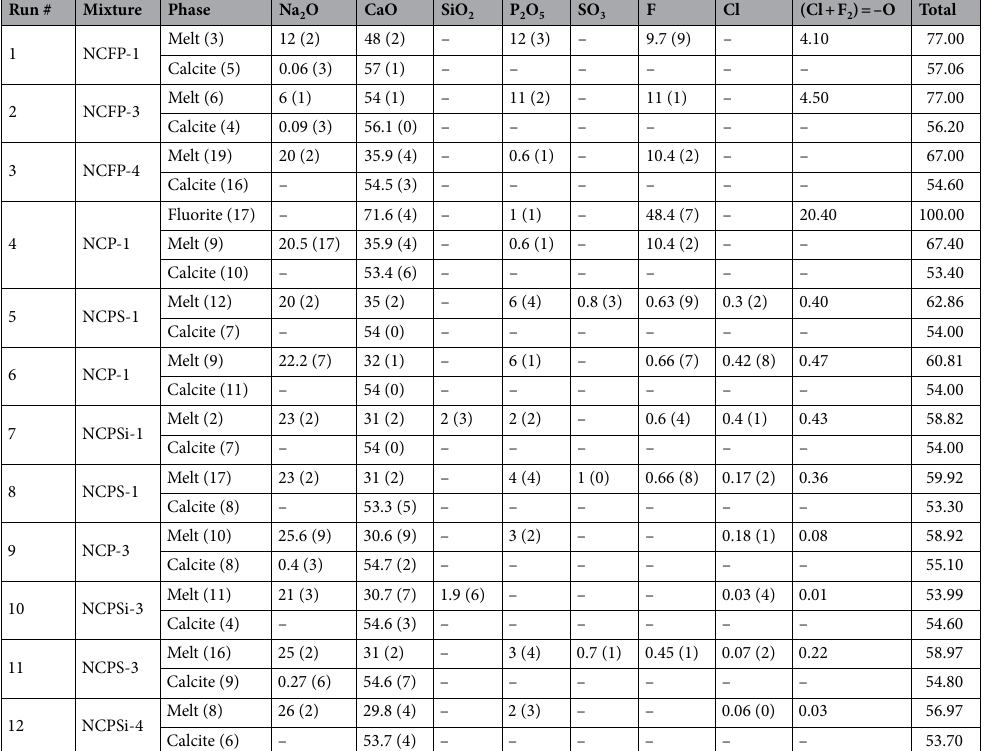
Table 3. Major composition of run products (in wt.%). The numbers in the parentheses next to the phase name indicates the number of analyzes. The numbers in the parentheses next to the analyzes are the standard deviation and reported as the least unit cited. For example, 55.50 (64) should be read as 55.50 ± 0.64